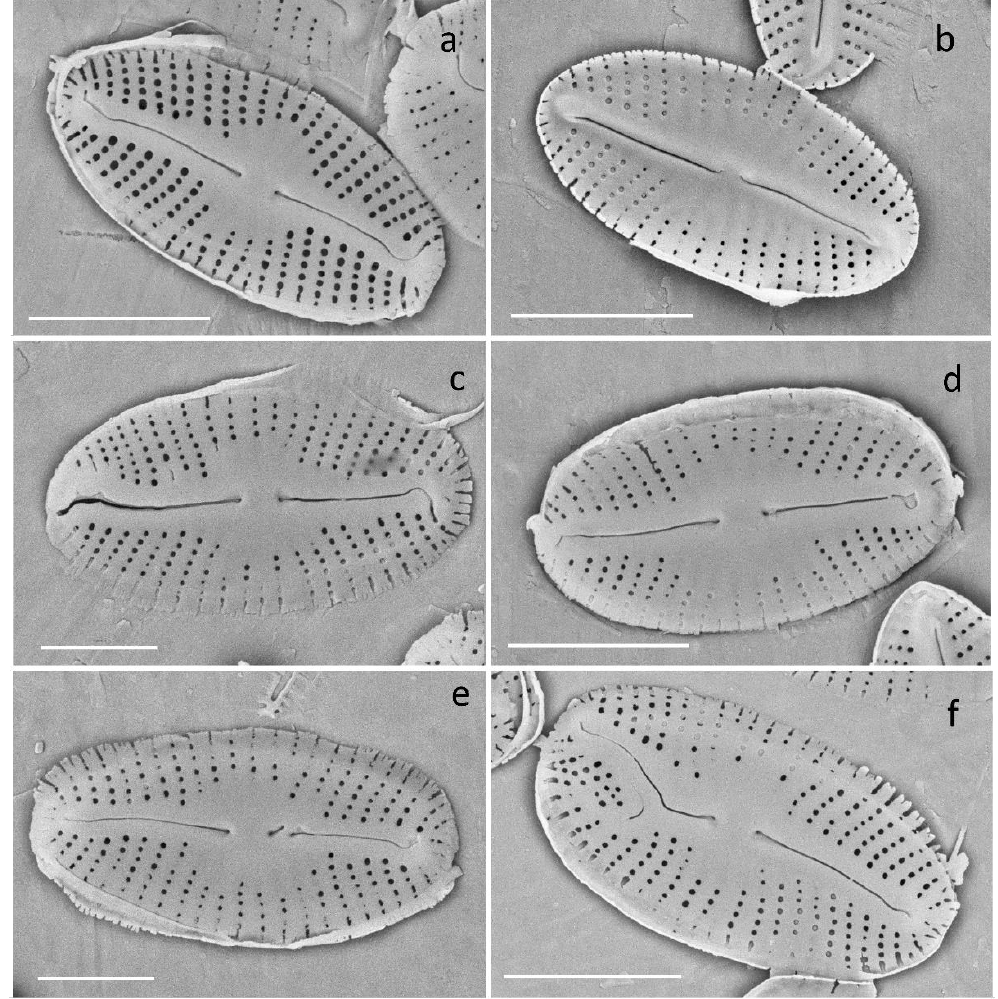
Figure 6. Mayamaea atomus SEM images of normal and deformed valves. ( a ) External valve view, typical valve raphe apices not equally formed. ( b ) Internal valve view, typical valve formation. ( c ) Axial and central areas symmetric, selected areolae deformed linear-slits. ( d ) Typical valve with deformed terminal raphe end. ( e ) Broken raphe at the central area. ( f ) Double raphe formation on one side of the valve and asymmetry of the valve. Scale bars: ( a , b , d , f ) = 5 µm, ( c , e ): 2 µm.